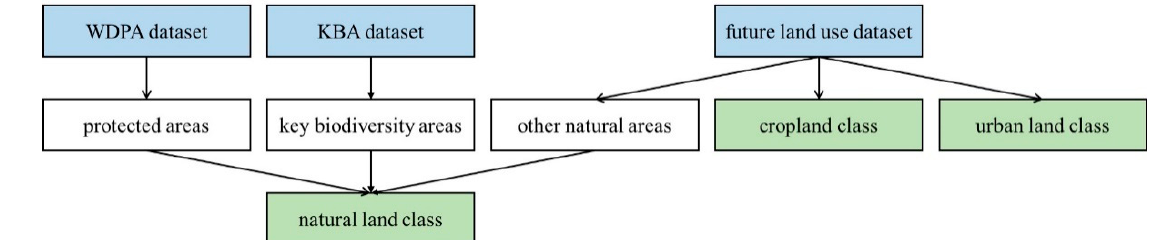
Figure 1. Flow chart of defining land classes. Blue represents input datasets. Green represents outputs in this step, which are land classes we define.